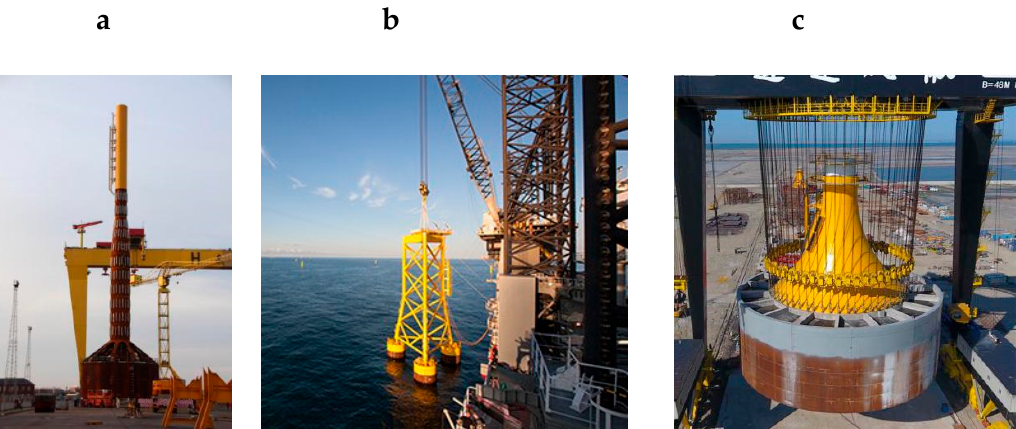
Figure 1. Offshore wind turbines with different types of bucket foundations: ( a ) mono-bucket foundation; ( b ) suction bucket jacket; ( c ) composite bucket foundation with multi-compartments.